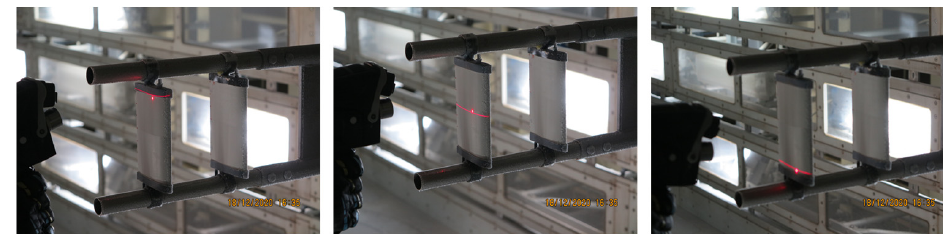
Figure 2. 3D laser scan reconstructions performed before and after IWT test 6.